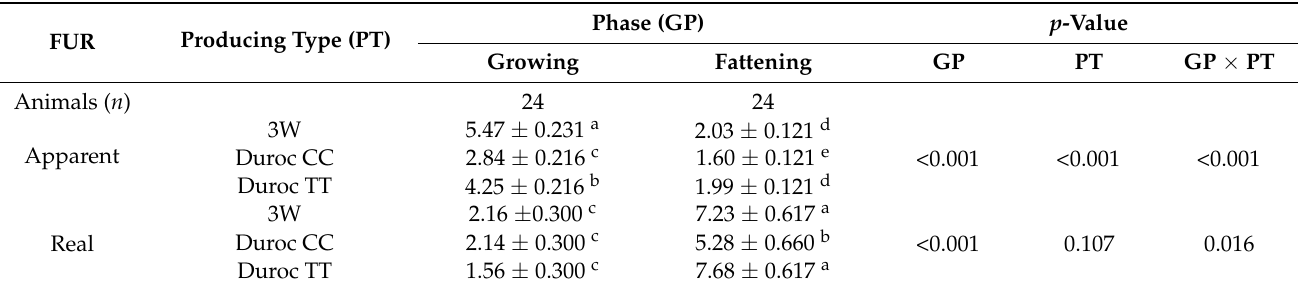
Table 6. Least square means ( ± SE) for apparent and real fractional unsaturated rate (FUR; %/day) in subcutaneous adipose tissue between three-way (3W) crossbred pigs and purebred Duroc of TT/CC SCD genotype, belonging to two growth phases (growing vs.